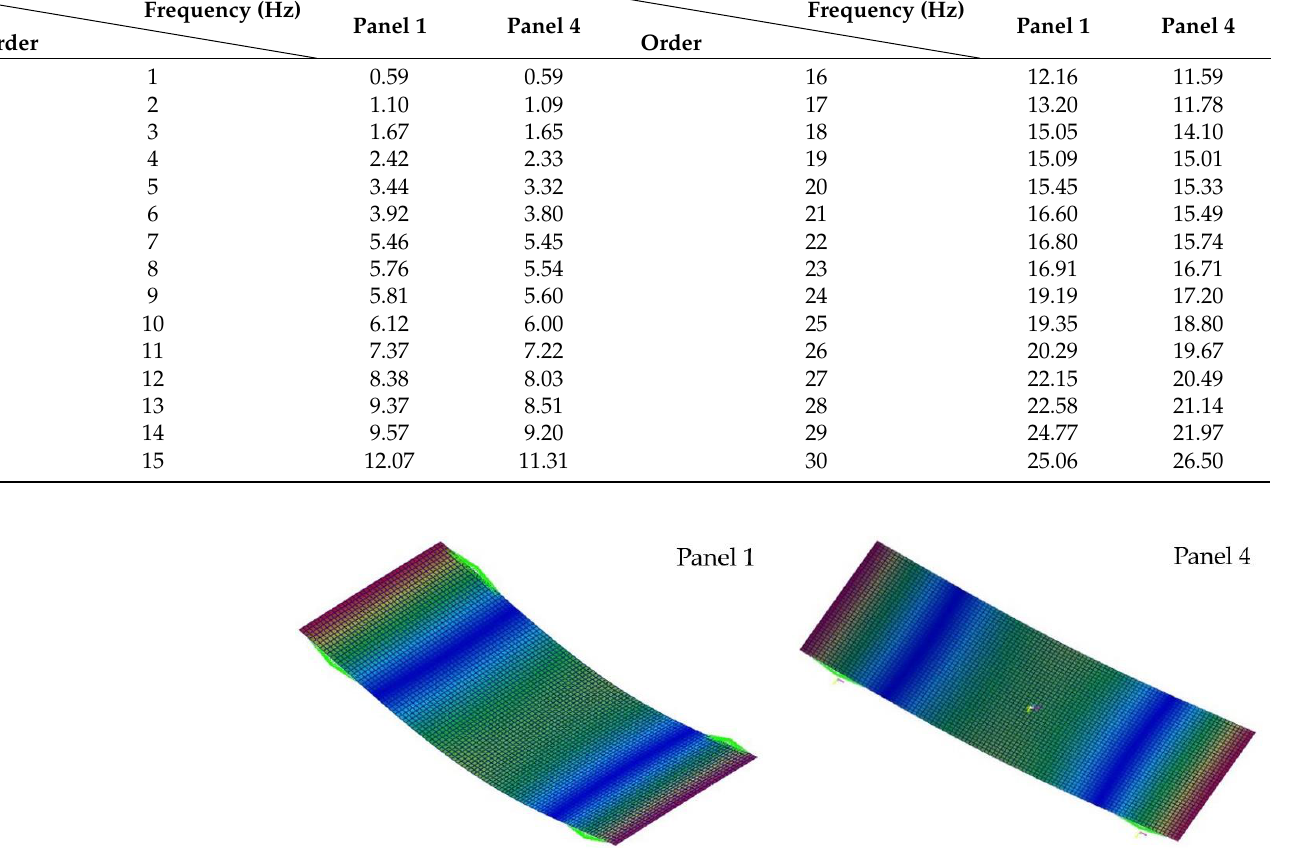
Table 4. First 30 natural frequencies of Panel 1 and Panel 4.